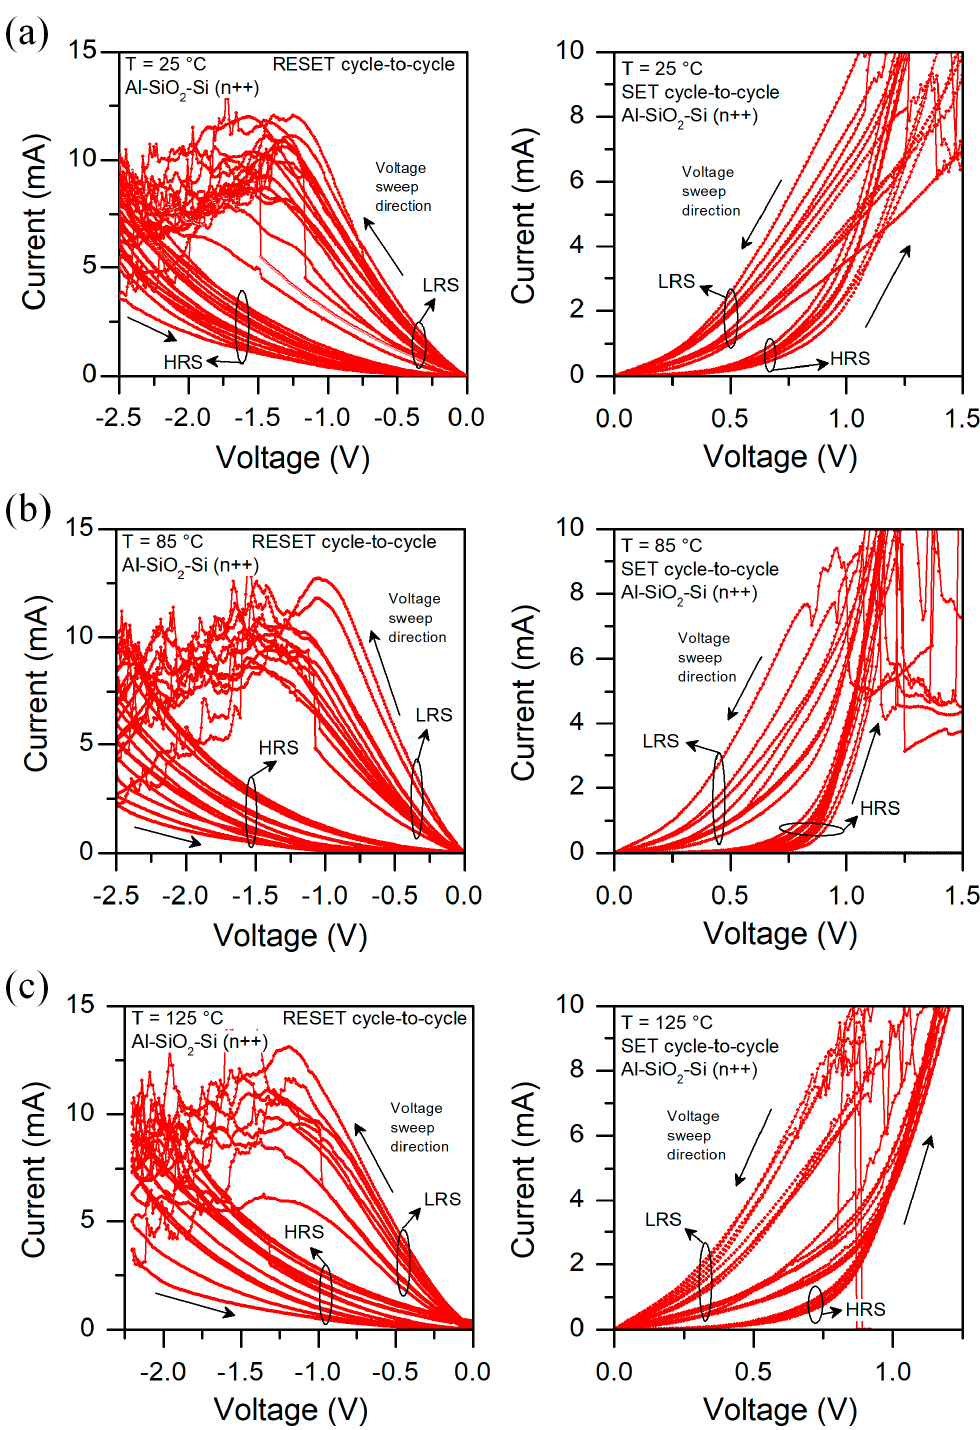
Figure 8. I-V characteristics of Al/SiO 2 /n++-Si RRAM device measured at ( a ) 25 °C, ( b ) 85 °C, and ( c ) 125 °C showing cycle-to-cycle variability. Arrows indicate the voltage sweep direction.